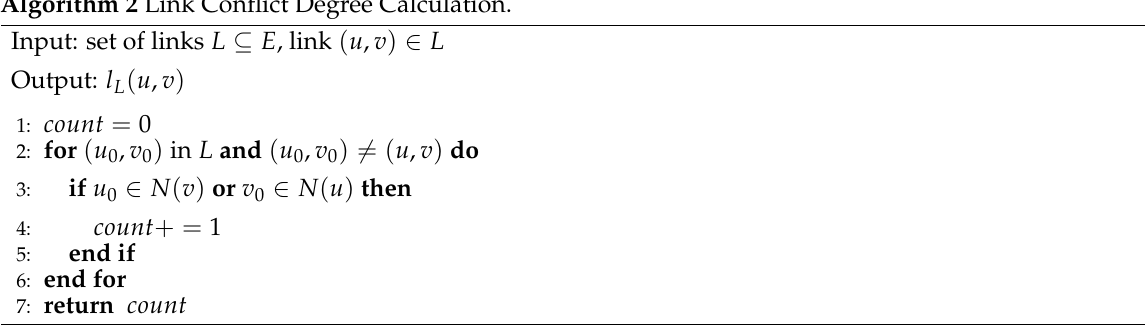
Algorithm 2 Link Conflict Degree